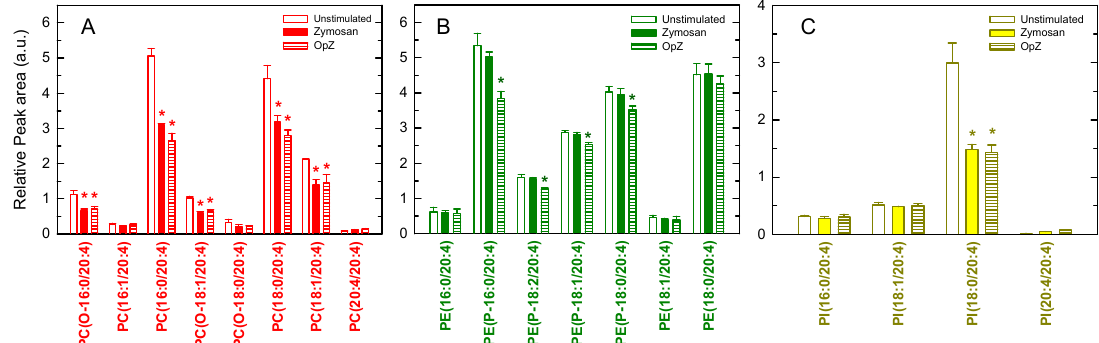
Figure 5. AA-containing phospholipid species in murine peritoneal macrophages and the effect of cellular stimulation. The cells were not stimulated (open bars) or stimulated with 1 mg/mL zymosan (closed bars) or 1 mg/mL OpZ (stripped bars). After 1 h, the cellular content of AA-containing choline-containing glycerophospholipid (PC) ( A ), ethanolamine-containing glycerophospholipid (PE) ( B ), and phosphatidylinositol (PI) ( C ) molecular species was determined by LC/MS. The data are expressed as mean values ± S.E.M. ( n = 6). * p < 0.05, significantly different from the corresponding species in unstimulated cells. a.u., arbitray units.